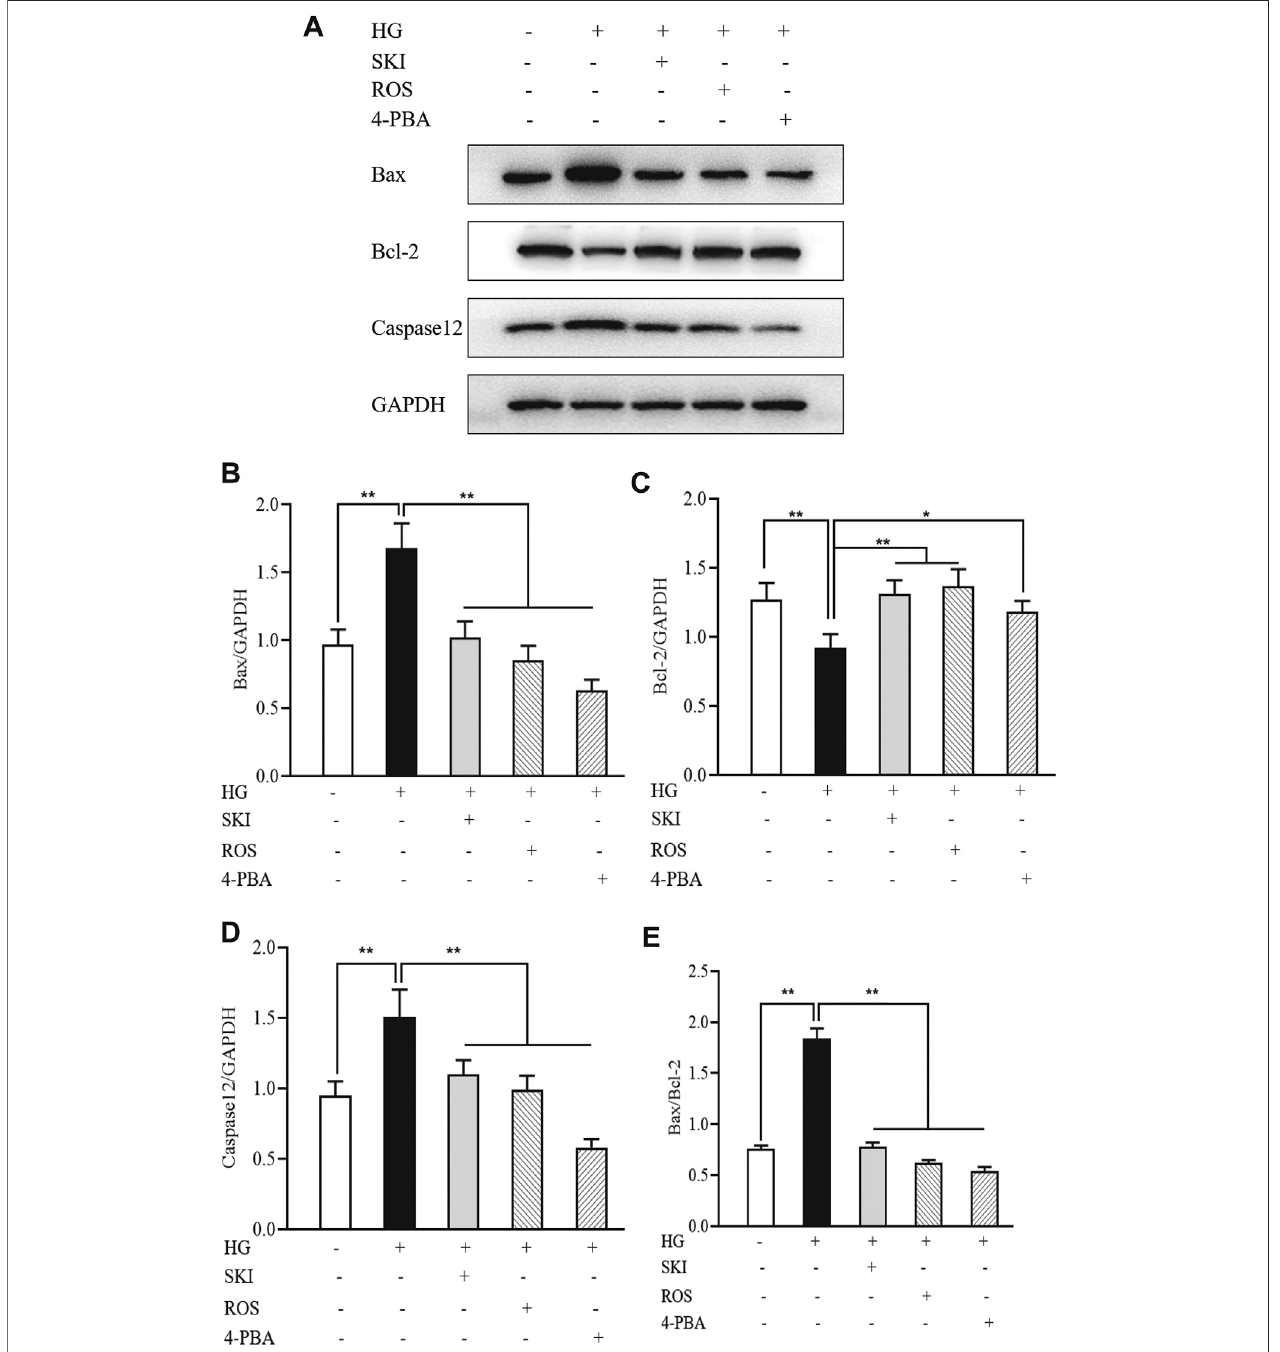
FIGURE 10 | The effects of SKI and ROS on the protein expression levels of Bax, Bcl-2, and caspase12, in vitro . (A) WB analysis of Bax, Bcl-2, and caspase12, in NRK-52EcellsexposedtoHGand4-PBAwithorwithoutSKIorROSfor24 h; (B – E) TherateofBax,Bcl-2,andcaspase12,toGAPDH,respectively,andtherateofBax to Bcl-2. Data are expressed as mean ± S.E. * p < 0.05, ** p < 0.01. Abbreviations: WB, Western blot; HG, high glucose; 4-PBA, 4-phenylbutyric acid; GAPDH, glyceraldehyde-3-phosphate dehydrogenase; ROS, rosiglitazone; SKI, Shenkang injection.